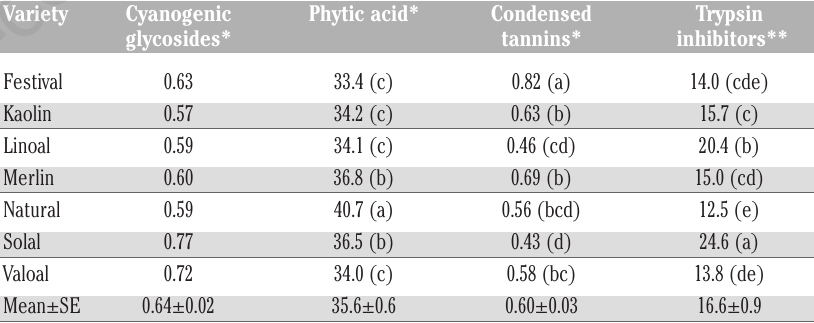
Table 2. Antinutritive compounds in flours of seven varieties of Linum usitatissimum . Variety